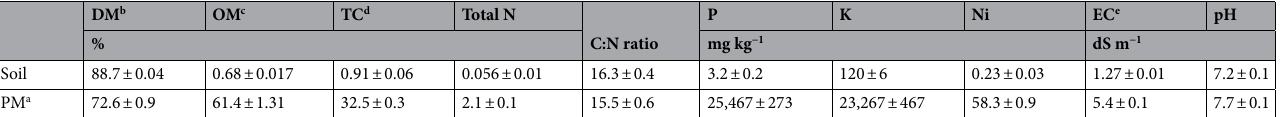
Table 1. Chemical characteristics of soil and poultry manure used in the study. a Poultry manure, b dry matter, c organic matter, d total carbon, e electrical